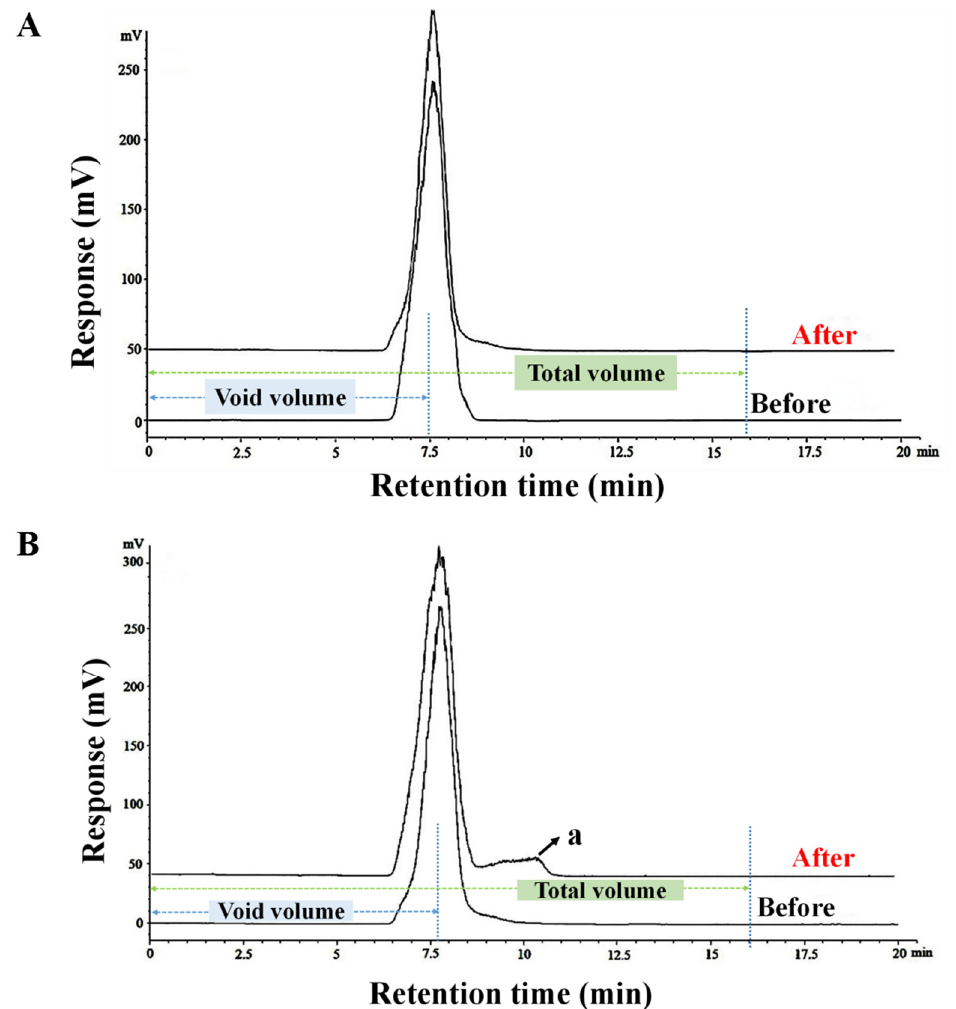
Figure 1. HPLC results comparison between LHEPS ( A ) and LPEPS ( B ) following in vitro simulated saliva and GSI digestion.